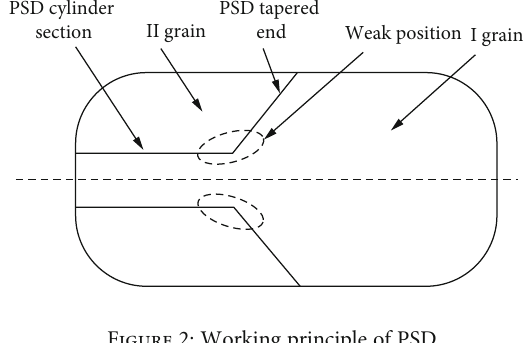
Figure 2: Working principle of PSD.